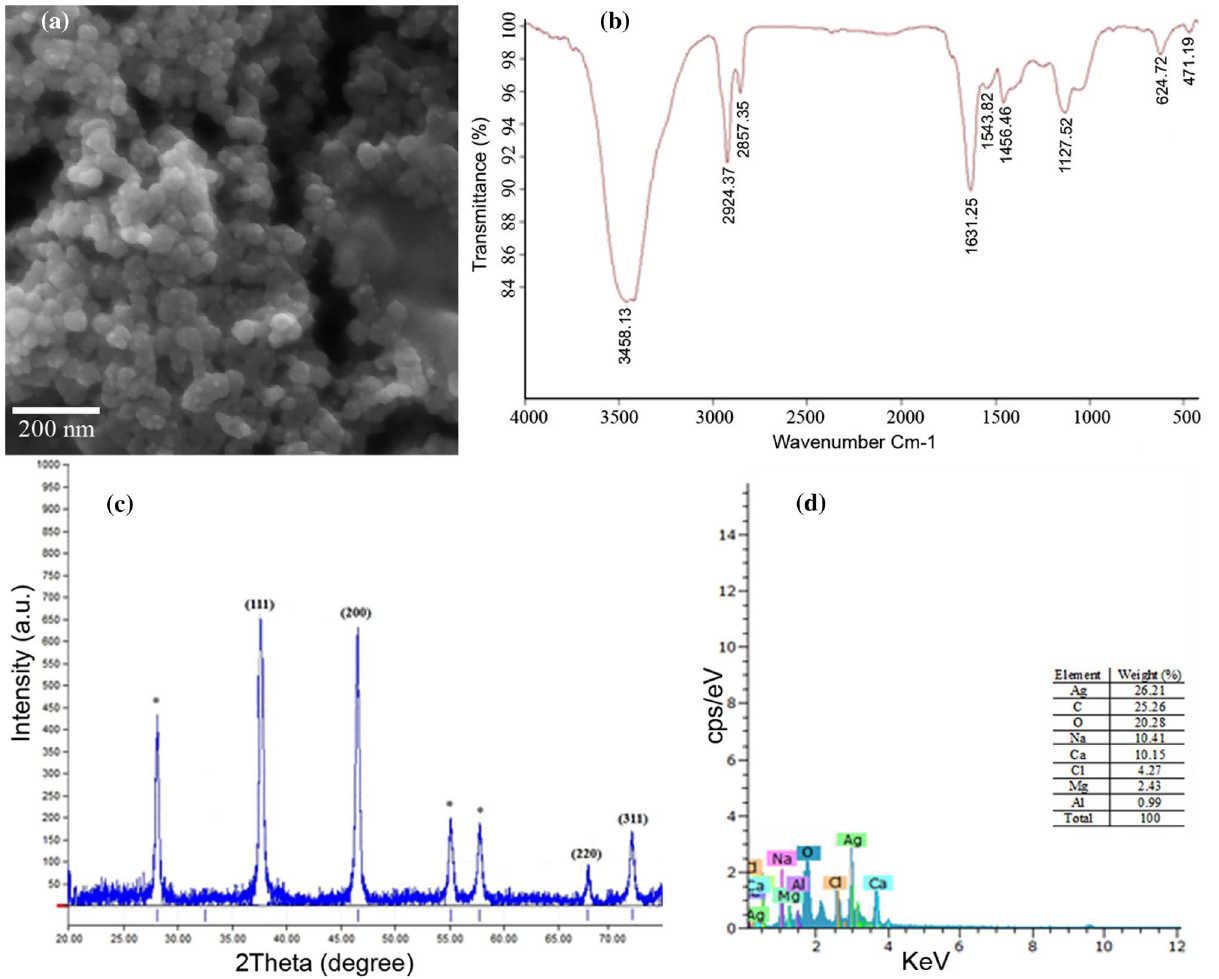
Figure 3. Characterization of AgNPs synthesized with Pseudomonas canadensis Ma1. ( a ) Scanning electron micrograph showing AgNPs in spherical forms about 21 ‒ 52 nm in diameter, ( b ) Fourier transform infrared (FTIR) spectrum showing functional groups responsible for the synthesis and stabilization of AgNPs, ( c ) X-ray diffraction (XRD) spectrum showing the nanoscale size and crystalline nature of the AgNPs, the unassigned peaks is labeled with (*), and ( d ) Energy dispersive spectrum (EDS) pattern showing the predominance of Ag element in the AgNPs